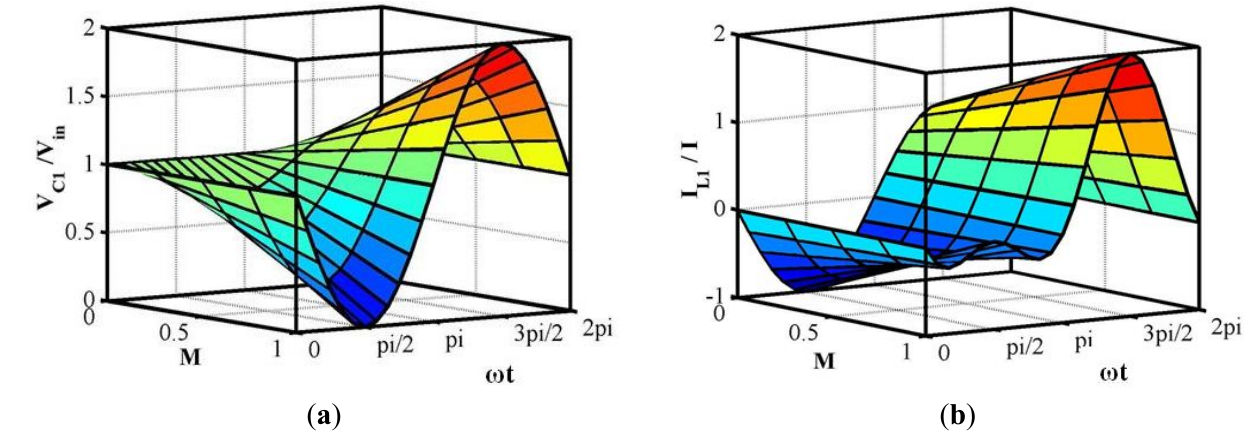
Figure 8. ( a ) Voltage across capacitor C vs. M and ω t L 1